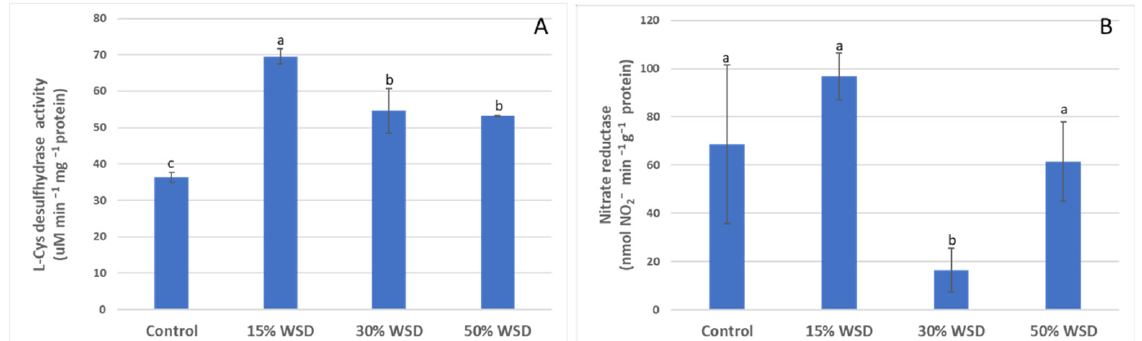
Figure 4. Changes in the L-cysteine desulfhydrase ( A ) and nitrate reductase ( B ) activities in control and dehydrated to 15%, 30%, and 50% WSD plants. Vertical bars indicate means ( n = 9) ± standard deviation. Letters indicate Fisher’s least significant differences, which were estimated at a significance level of α = 0.05.